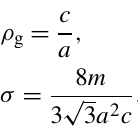
Figure 9. Temperature dependence of polarizability ratios for ice crystals grown in the free-fall chamber (blue filled circles) and for ones located close to tops of mixed-phase clouds, retrieved from hy- brid MIRA-35 (red filled circles). Note that ρ e > 1 corresponds to prolate particles and ρ e < 1 corresponds to oblate particles. Vertical red bars represent ± 1 standard deviation of observed polarizabil- ity ratios. Data from the free-fall chamber (Takahashi et al., 1991) were provided by Prof. Takahashi, Hokkaido University of Educa- tion, Sapporo,